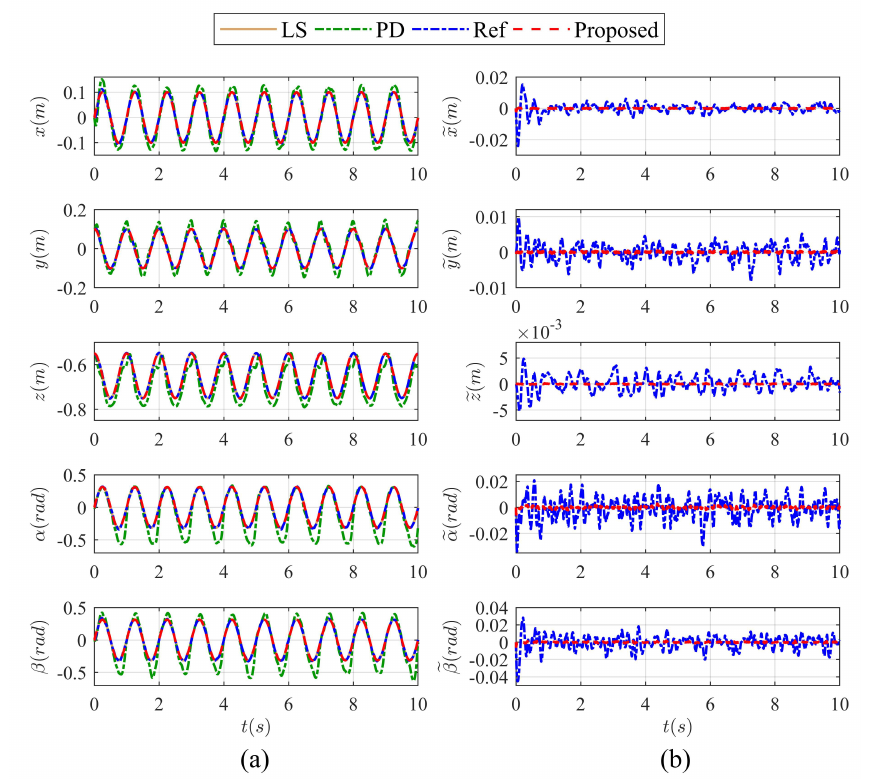
Figure 12. Tracking performance of the generalized coordinates of the 5-DoF spatial PM for case 2: ( a ) comparison of trajectory tracking with different controllers and ( b ) comparison of tracking error between the dynamic feedforward controller and proposed controller.